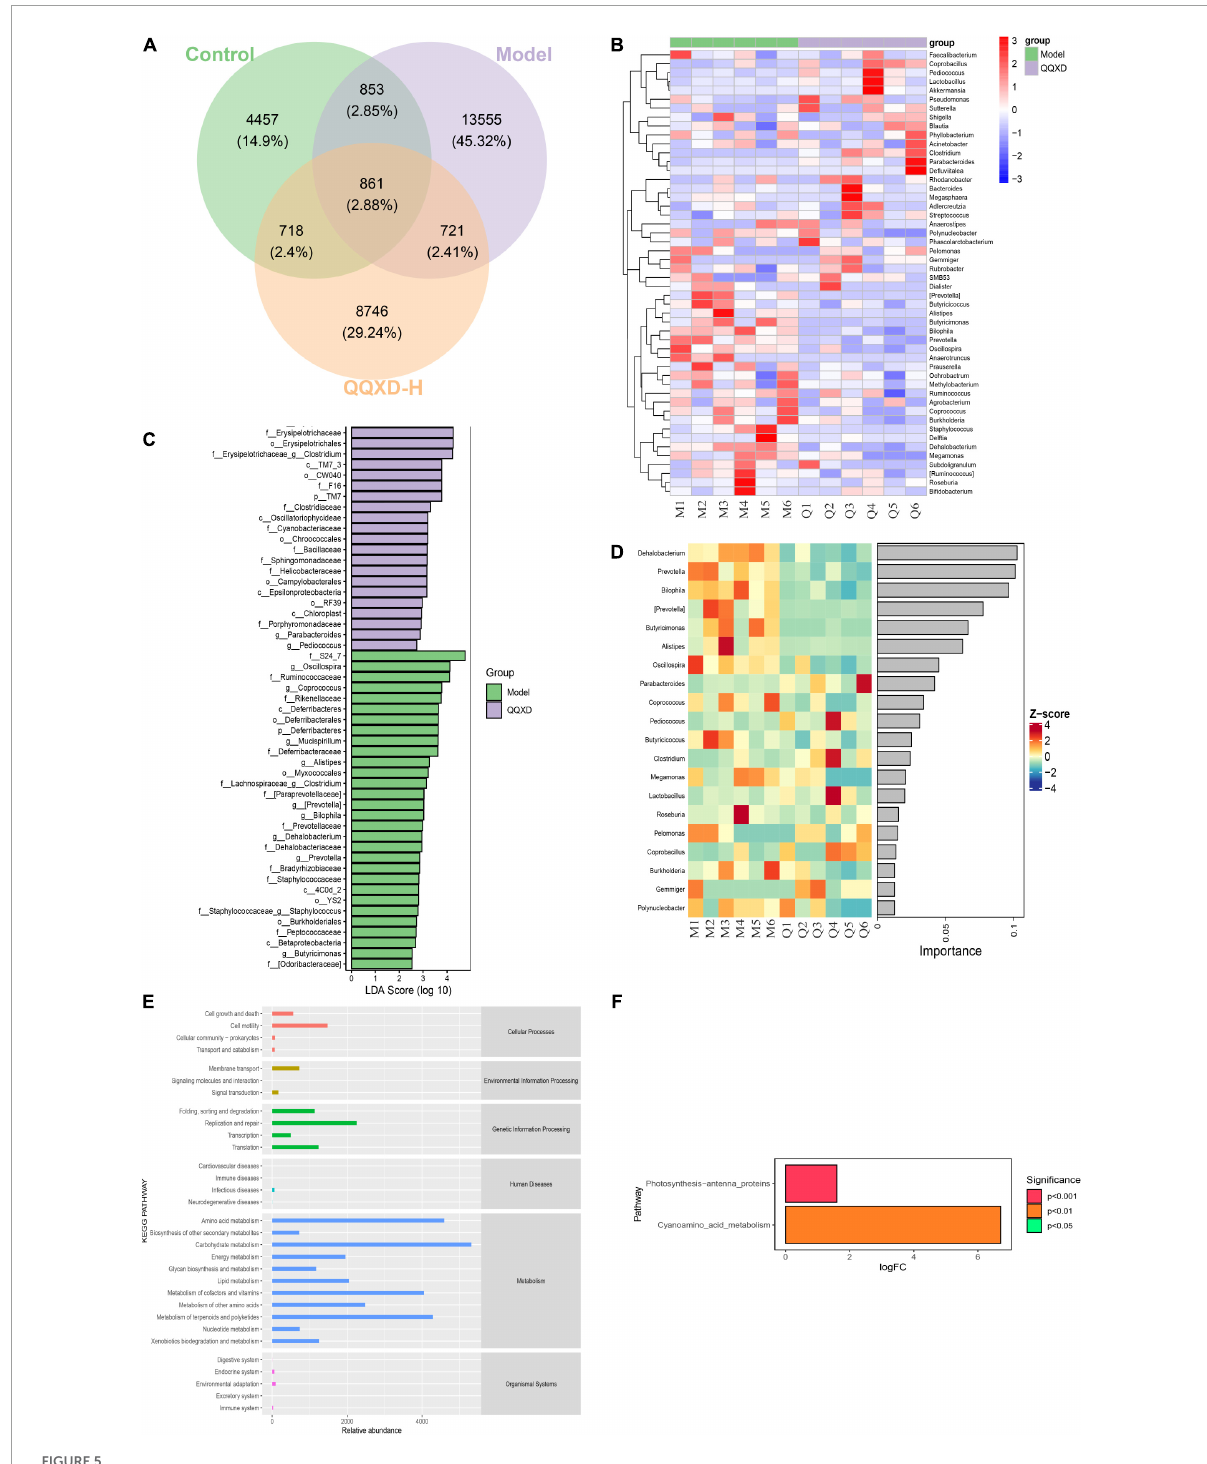
FIGURE5 Analysis of differential flora and pathway enrichment. (A) Venn diagram of differential flora. (B) Genus level species composition cluster heat map. The red color block indicates that the abundance of this genus in this sample is higher than that in other samples, and the blue color block indicates that the abundance of this genus in this sample is lower than that in other samples. (C) Histogram of LDA effect values of marker species. (D) Top 20 important flora in genus level. (E) KEGG secondary function channel abundance diagram. (F) Difference between QQXD and Model KEGG metabolic pathway. A positive value of logfc on the horizontal axis indicates that QQXD is up-regulated [log2 (fold change)] relative to the Model, and a negative value indicates that it is down-regulated; the ordinates are labels of different KEGG metabolic pathways; Show the degree of significance in different